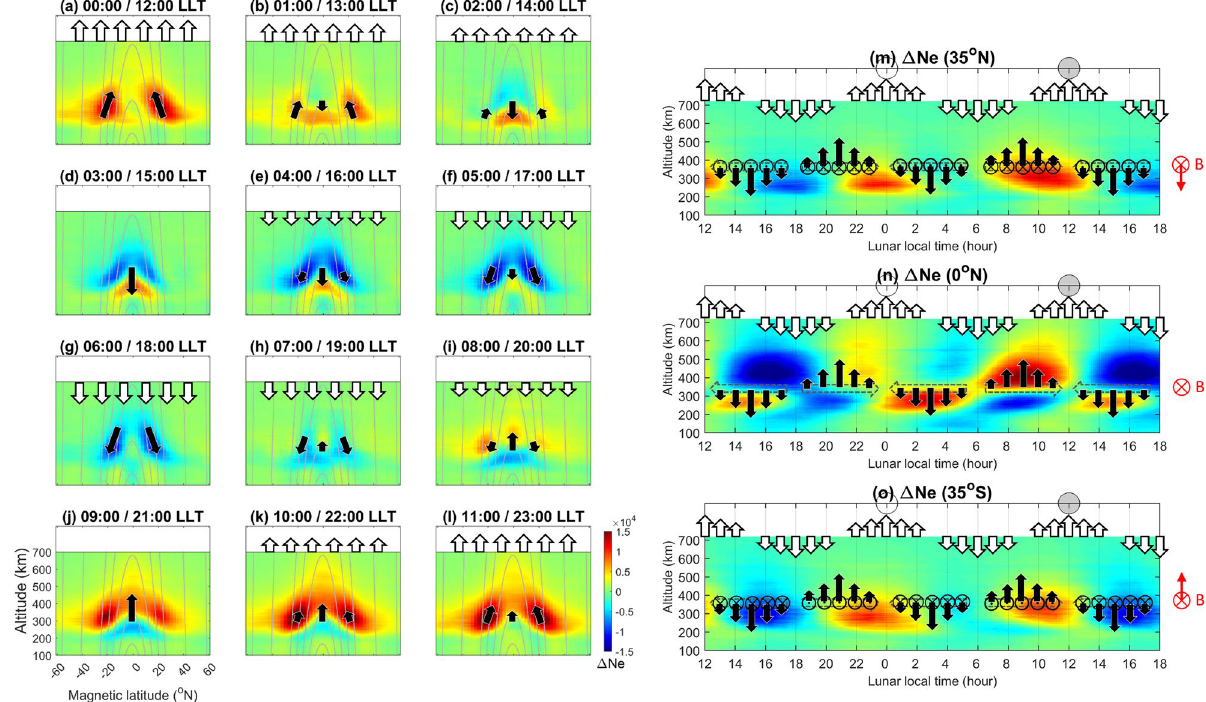
Figure 5. ( a – l ) Altitude-magnetic latitude slices F3/C and F7/C2 electron density, where the gray curves denote the magnetic field, and the black arrows stand for bulk plasma motions. Altitude-lunar local time slices at the ( m – o ). magnetic equator and ± 35° N magnetic latitudes. The Earth’s magnetic field is in the inward direction at the magnetic equator and in the up-inward/down-inward direction at ± 35° N magnetic latitudes. Dashed arrows stand for responses of eastward and westward horizontal neutral winds to the lunar gravitational force. Therefore, black arrows denote plasma drifts driven by the neutral